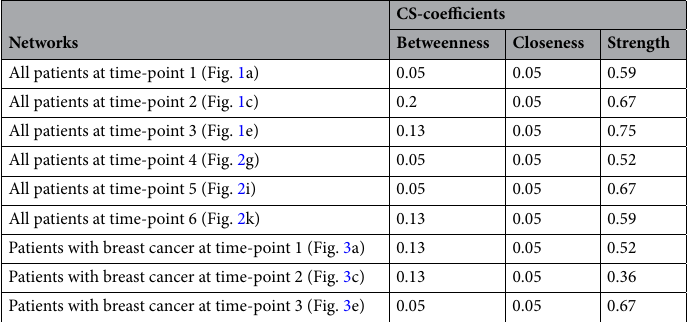
Table 3. Correlation stability (CS) coefficients for all